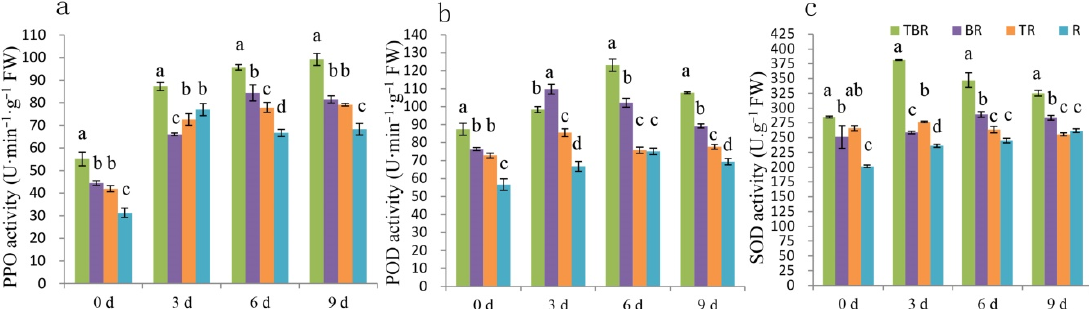
Figure 2. Effect of Trichoderma virens and Bacillus velezensis on induction PPO, POD, and SOD activities in tomato plants. The treatments were as follows: R = Ralstonia solanacearum (RS-15); TR = Trichoderma virens (Tvien6) + RS-15; BR = Bacillus velezensis (X5) + RS-15; and TBR = Tvien6 + X5 + RS-15. The values of SOD ( c ), POD ( b ), and PPO ( a ) activities are shown as the mean of three replications ± standard deviation (SD); different lowercase letters on the columns indicate that there were significant differences ( p < 0.05) among different treatments.